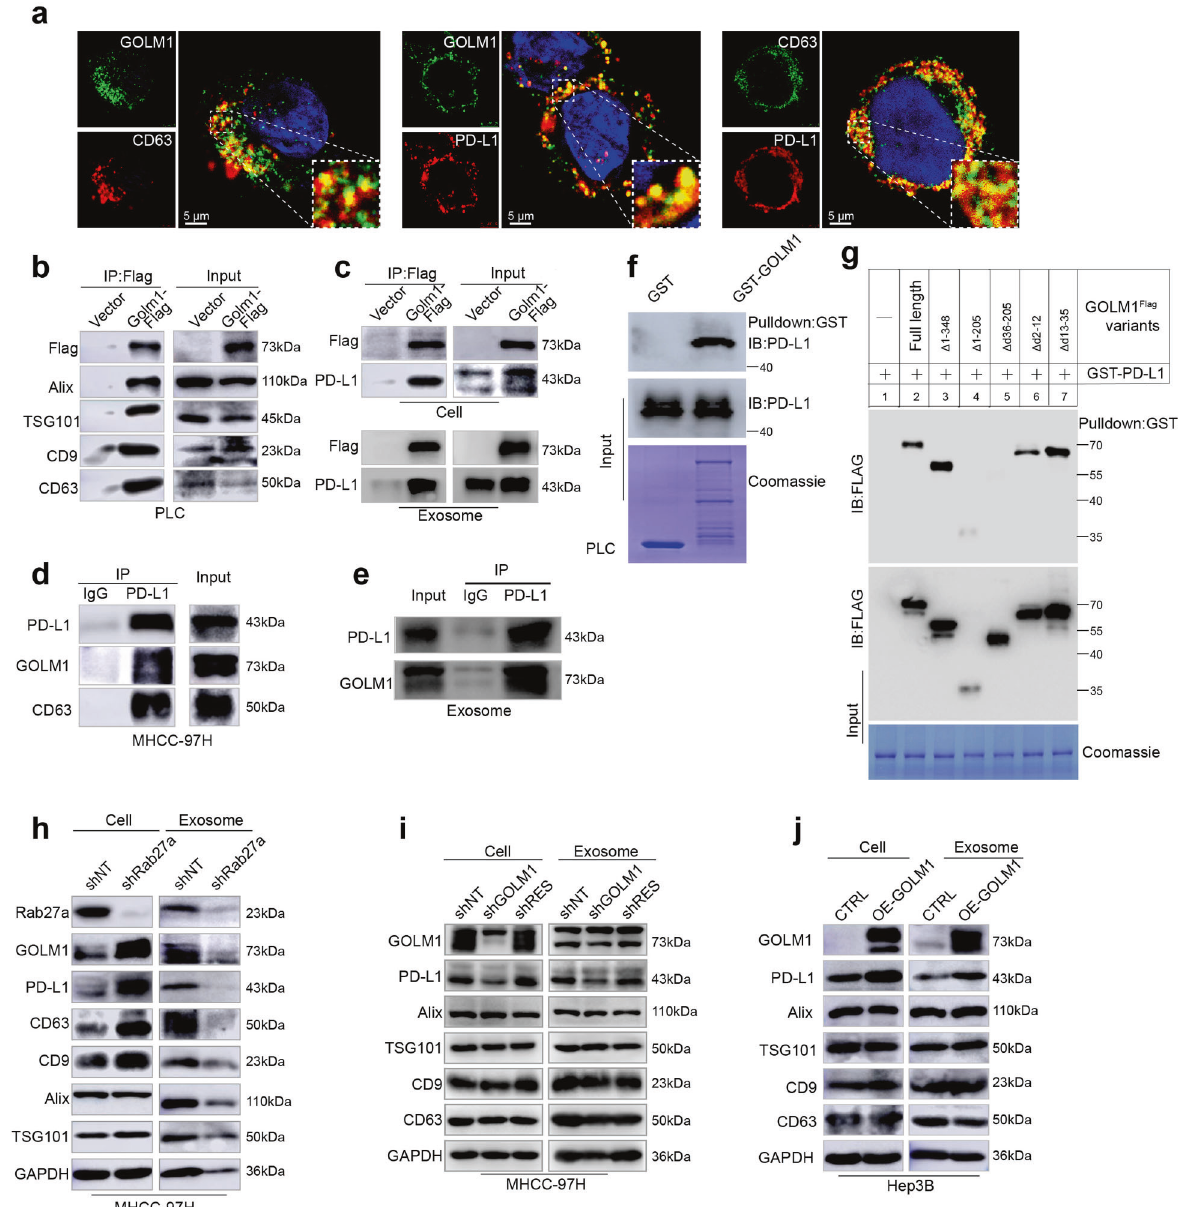
GOLM1 Flag PLC cells and exosomes: PLC cells transfected with FLAG-GOLM1 or empty vector (control) were subjected to IP using anti-FLAG magnetic beads. d The association of endogenous PD-L1 with GOLM1 and CD63 in MHCC-97H cells was validated. e The association of endogenous PD-L1 with GOLM1 in MHCC-97H exosomes was validated. f GST pulldown assays showed a direct interaction between GOLM1 and PD-L1. GST- GOLM1 was expressed in E. coli and puri fi ed. Full-length PD-L1 was produced via in vitro translation. g Mapping the regions of GOLM1 that interact with PD-L1. Various FLAG-tagged truncated GOLM1 were prepared to test the interaction with GST-PD-L1, GOLM1 was detected by anti-Flag antibody after GST pulldown. Coomassie blue staining of one-tenth of the amount of each GST-PD-L1 fragment. h Western blotting analysis showed after Rab27a was knocked down, intracellular accumulation of PD-L1 and GOLM1 was detected in MHCC- 97H cells, whereas PD-L1 and GOLM1 in exosomes decreased signi fi cantly, and the abundance of exosomes, indicated by exosomal markers, ALIX, TSG101, CD63, and CD9, was inhibited signi fi cantly. i , j Western blot analysis of the exosomes isolated from an equivalent number (6 × 10 7 ) of HCC cells indicating that GOLM1 facilitates the secretion of exosomal PD-L1. MHCC-97H cells with endogenous high-GOLM1 ( i ) and low-GOLM1 Hep3B cells ( j ) were